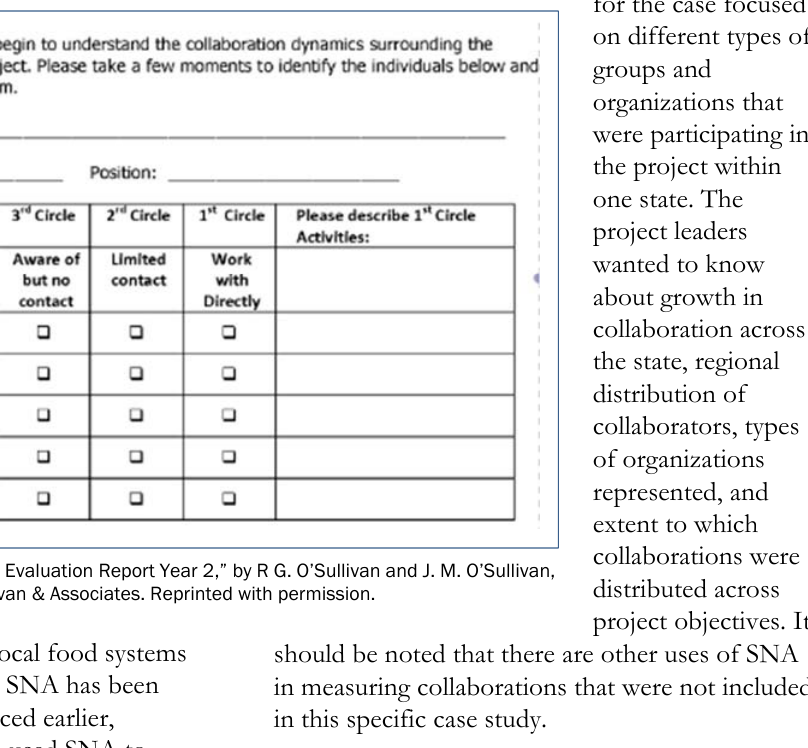
Figure 3. Example of Watershed Network Collaboration